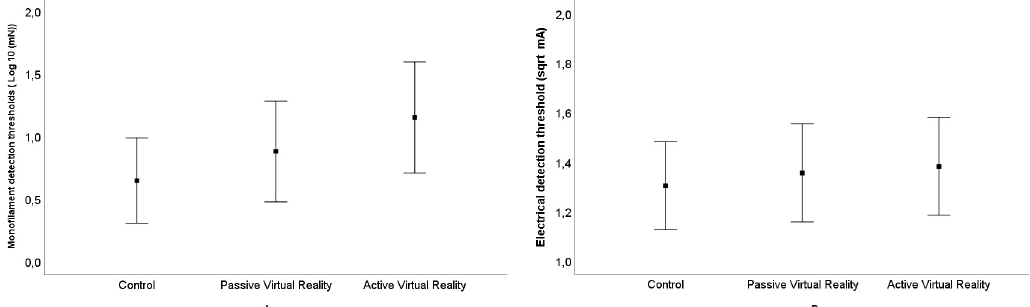
Fig 3. Tactile perception thresholds (mean and SD). A: Monofilament detection thresholds (MDT) after logarithmic transformation, B: Electrical detection thresholds (EDT) after square root transformation.